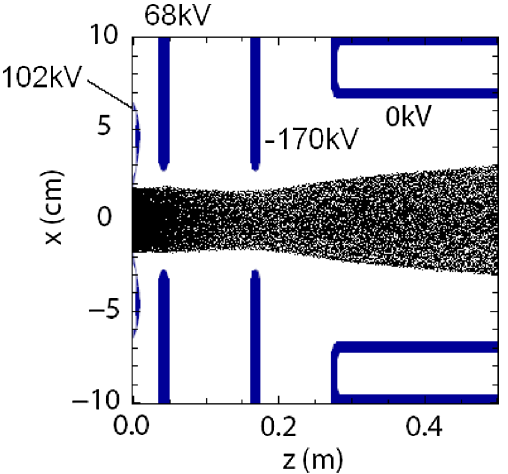
FIG. 8. (Color) The lithium diode injector and snapshot of the